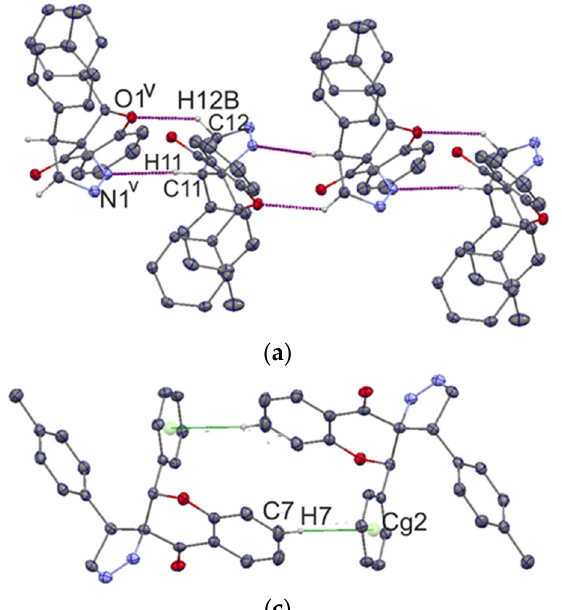
Figure 5. Fragment of the crystal packing of compound II , showing ring R 22 (8) formed on the base of two chains: C(6) and C(4) formed by C12–H12B…O1 v and C11–H11…N1 v hydrogen bonds ( a ), and chain C(8) formed by a C24–H24…O4 vi hydrogen bond ( b ). The dimer formed by C–H… π in- teractions is also presented ( c ).